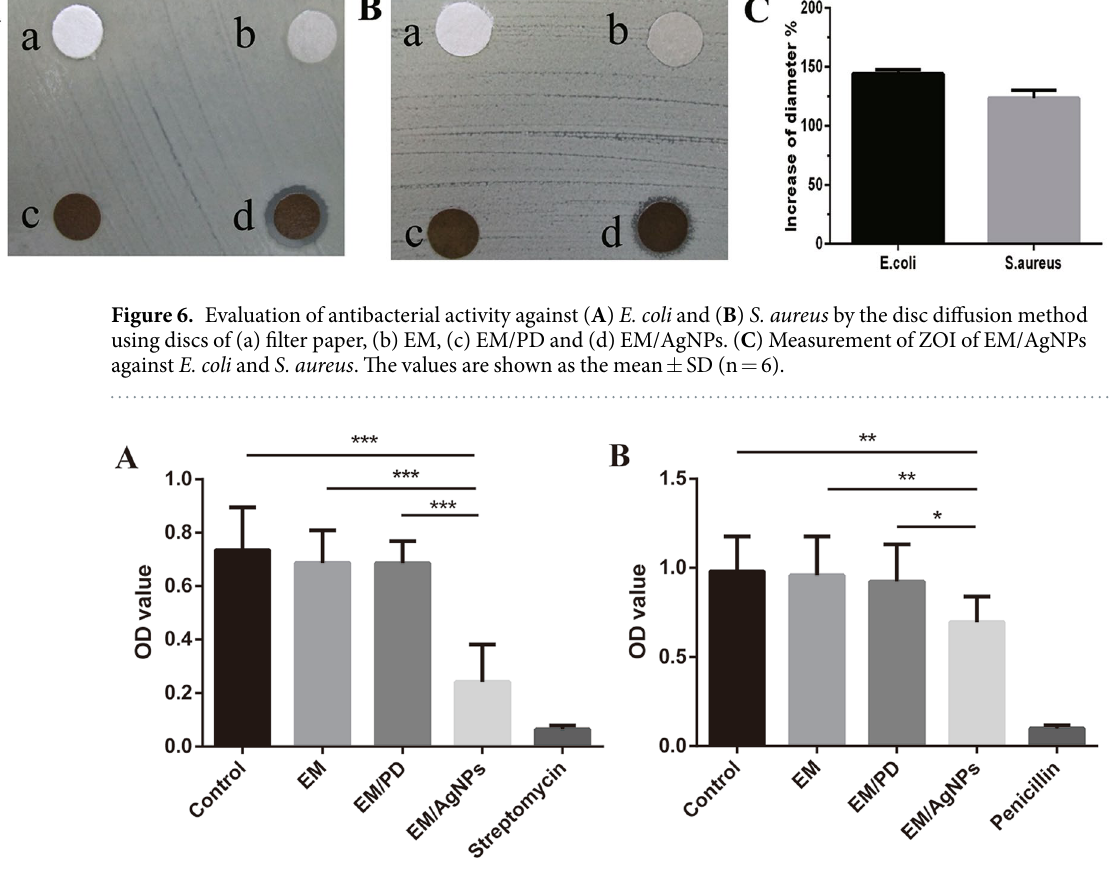
Figure 7. OD 600 value measurements of ( A ) E. coli and ( B ) S. aureus bacterial suspensions after 24 h of incubation. The values are shown as the mean ± SD (n =